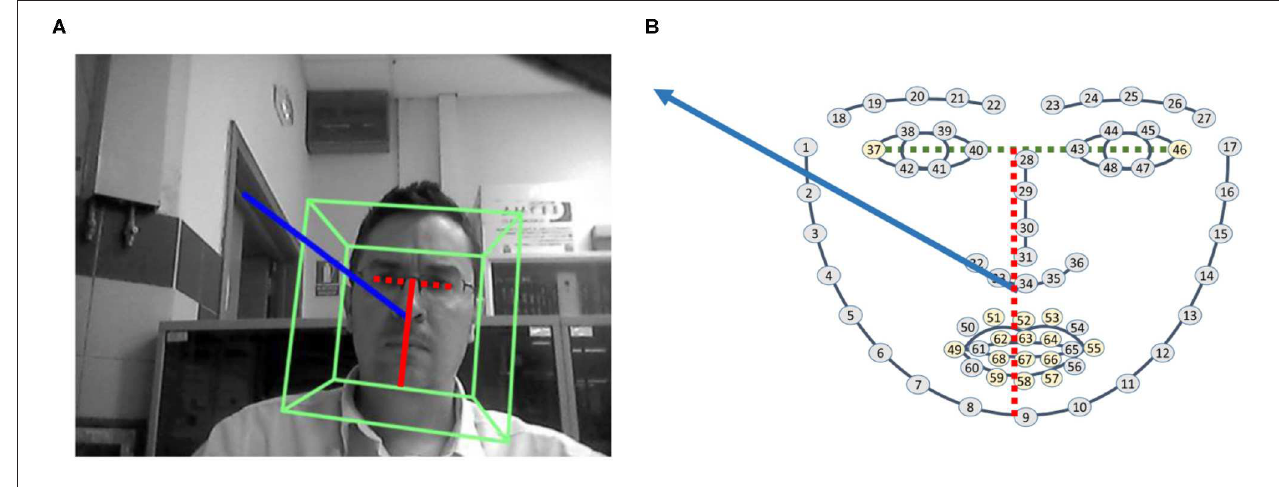
FIGURE 3 | Pose module and distance between eyes and chin. (A) Pose of a person. (B) Pose vector and DLIB